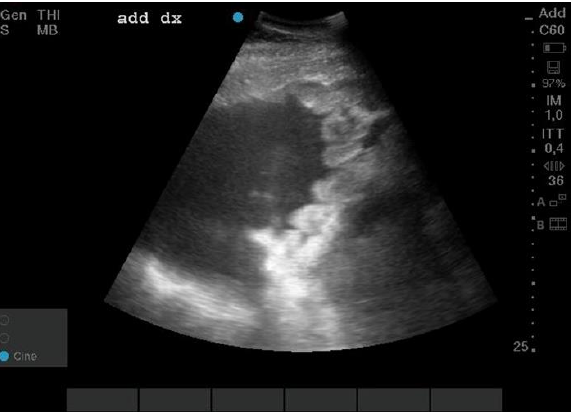
Figure 1. Abdominal ultrasound. Right middle abdomen window: presence of abundant amount of free hypoechoic fluid, and thickening of the parietal peritoneum where rounded formations adhere to clusters.